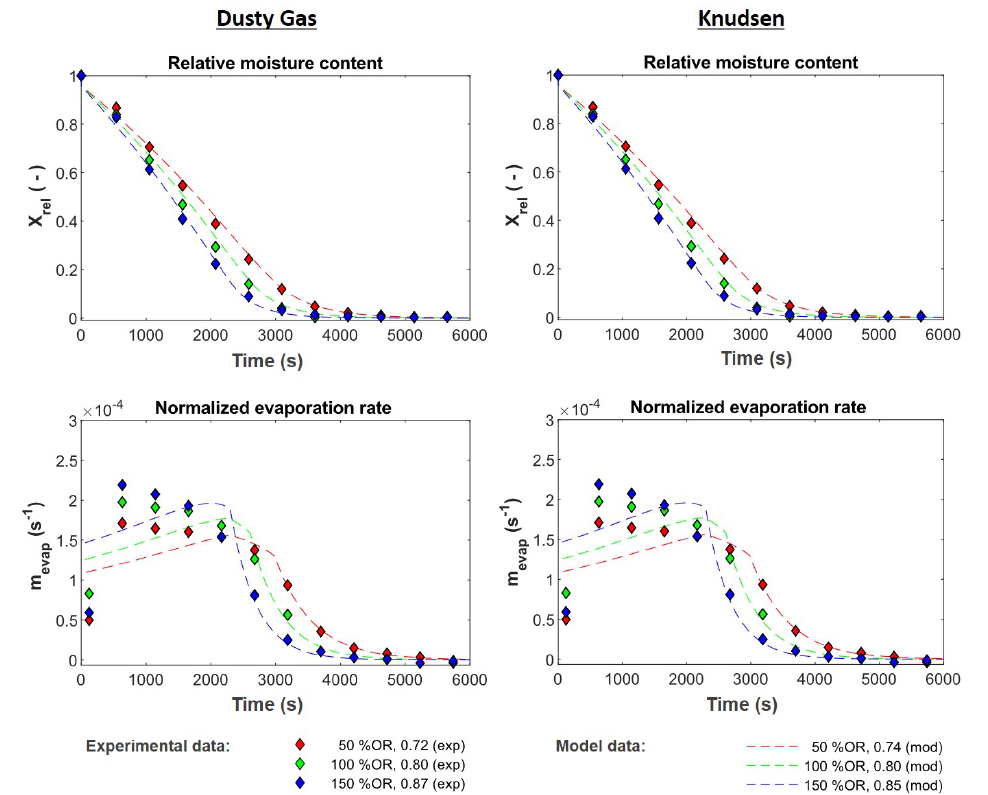
Figure 4. Validation of Knudsen model and dusty gas approach by means of experimental data during the freeze-drying of instant coffee granules by variation of overrun and the total porosity of the sample. Measured and calculated porosities for each sample are shown in the legend of each